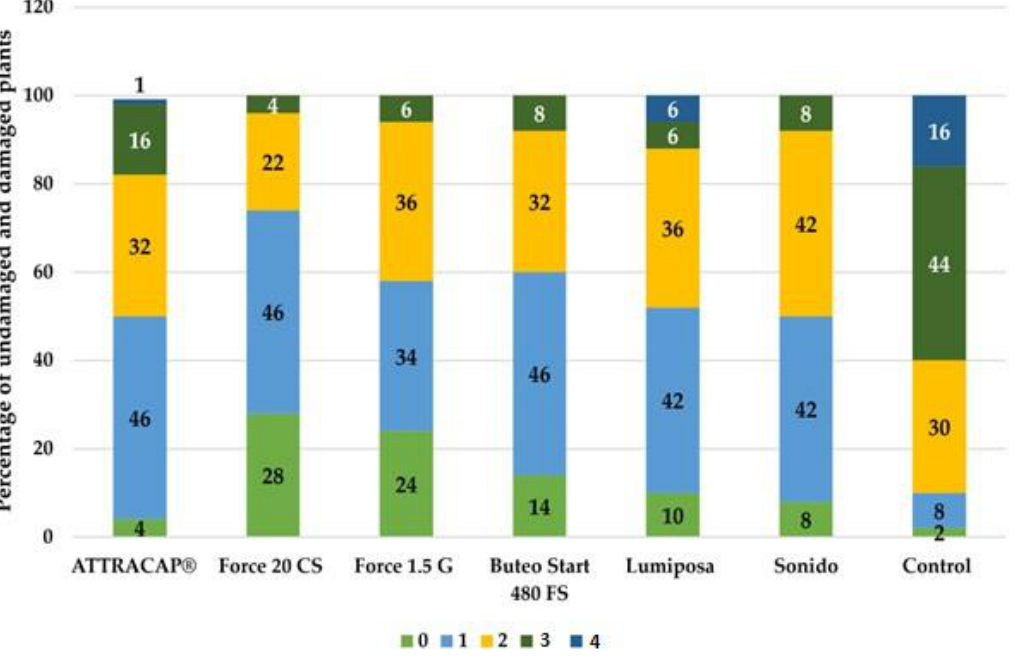
Figure 7. Percentage of plant damage levels 0-4 in different insecticidal treatments in the sunflower field RŠ Field 1 in the year